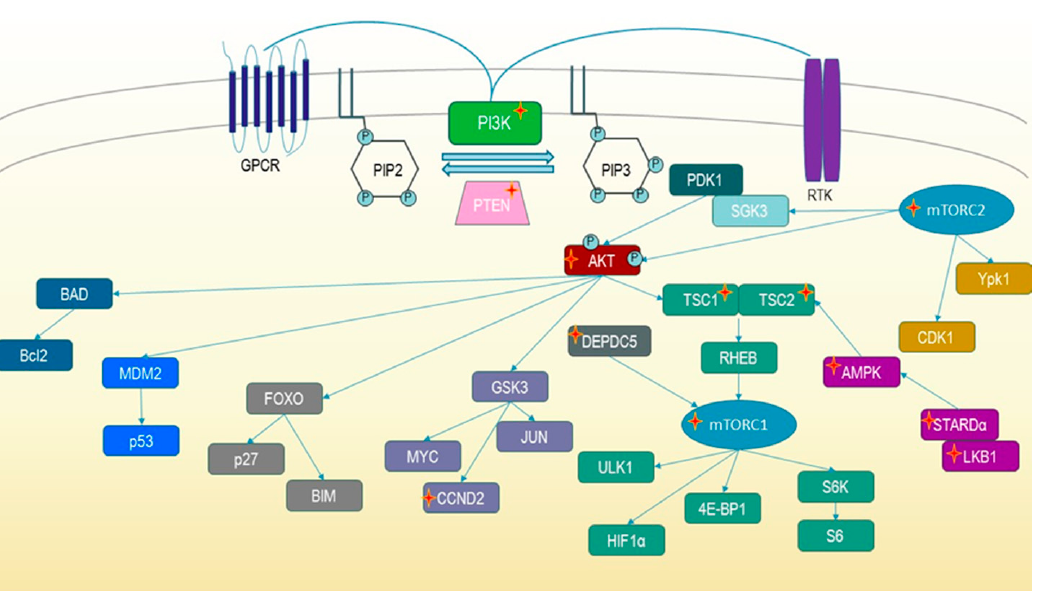
Table 1. Gene mutations of the PI3K/mTOR signaling pathway and associated genetic syndromes.